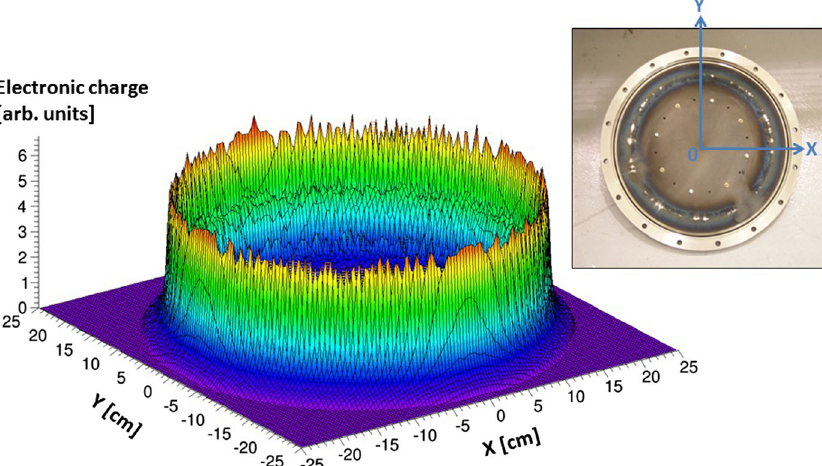
FIG. 11. 3D plot of the beam distribution at the target plane (in Cartesian coordinates). The image on the right is a picture showing wear on the graphite target after more than 2000 shots LAD. Target damage is visible primarily at large radius ( R ∼ 20 cm).